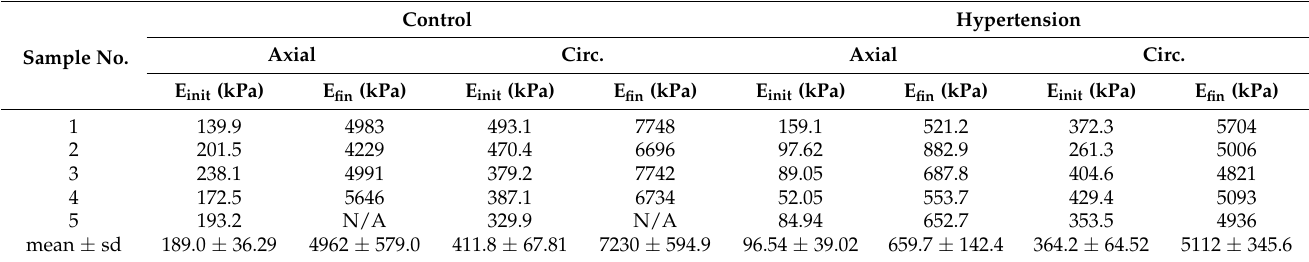
Table 3. Calculated values of tangent moduli (E init , E fin ) for the control and hypertension groups in axial and circumferential directions. The mean and standard deviation of the data groups are also